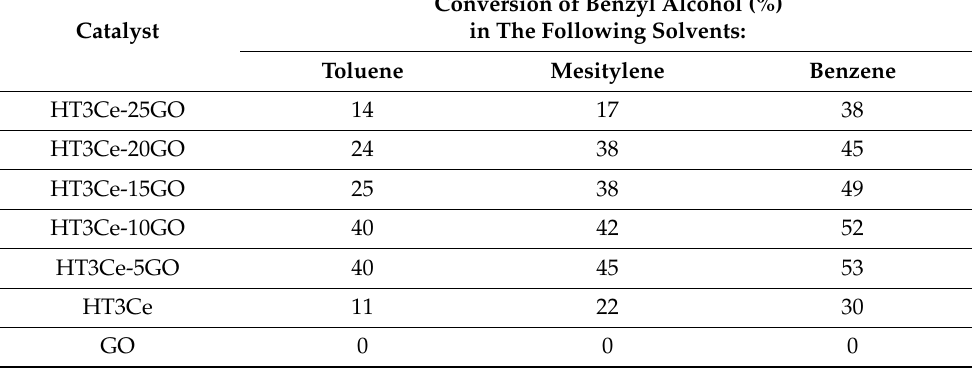
Table 5. Catalytic results of the HT3Ce-xGO composites containing different concentrations of GO ( x = 5, 10, 15, 20, 25 wt.% GO) in the one-pot oxidation–Knoevenagel condensation cascade reaction performed in different solvents: toluene, mesitylene, and benzene. Conversion of Benzyl Alcohol Catalyst